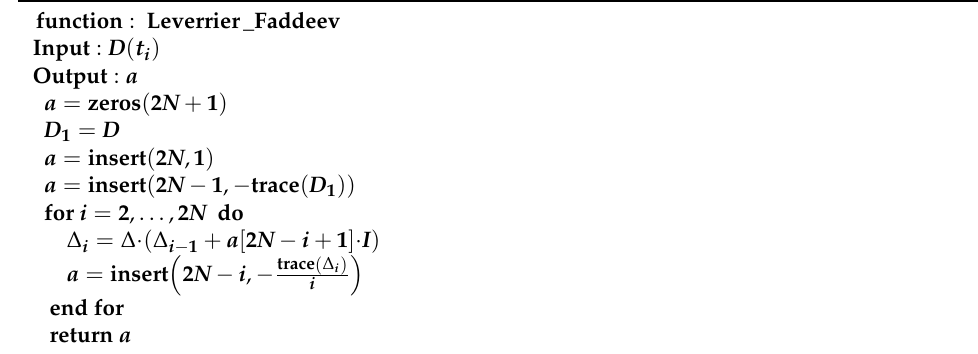
Table 3. The Leverrier–Faddeev